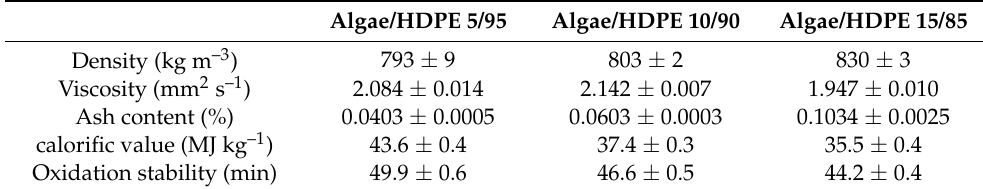
Table 4. Oil properties of three mixtures of macroalgae and HDPE pyrolysis